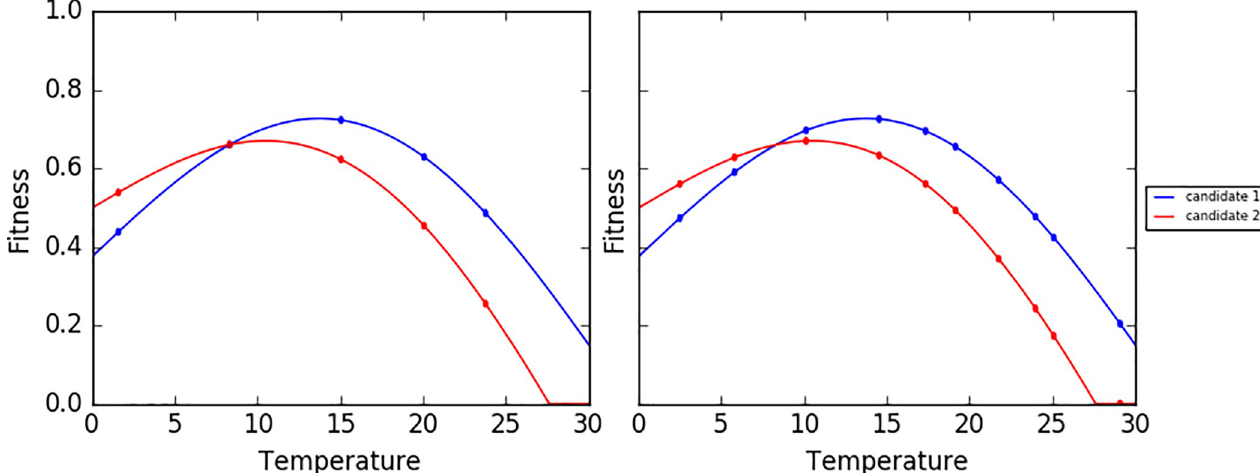
Fig 2. Illustration of the fitness surface of two hypothetical candidate solutions in an environment that varies with respect to a single parameter (e.g. an environment where the temperature varies in the range [0, 30] o C). Assuming that the temperature varies with a uniform distribution, the expected fitness of the two candidate solutions corresponds to the average height of the two curves, i.e. 0.55 and 0.46 for candidate solutions 1 and 2. In general, the higher the number of evaluation episodes, the better the precision of the estimation. The circles in the left and right pictures show the fitness measured during 5 and 10 evaluation episodes, respectively, in which the value of the temperature was set randomly. The offset between the average value of the fitness obtained during the evaluation episodes and the expected fitness amount to 0.036 and 0.021, in the case of the left and right picture respectively.